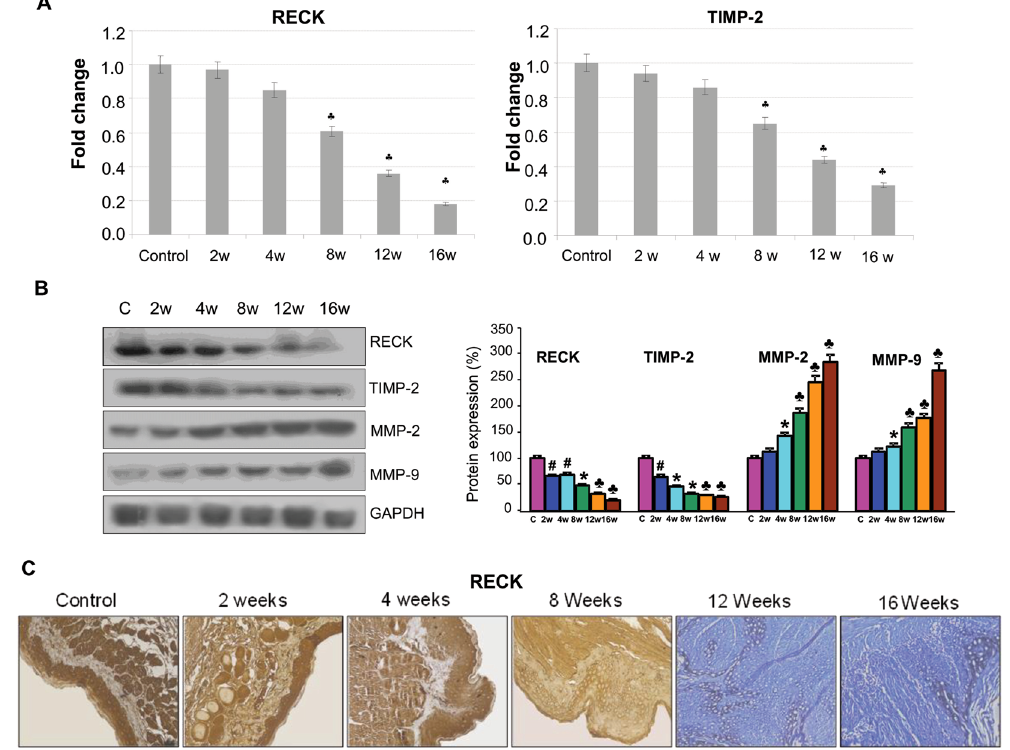
Figure 1. RECK is downregulated during sequential progression of HBP carcinoma. ( A ) qPCR analysis shows that RECK and TIMP-2 are downregulated during sequential progression of cancer. Data are the mean ± SD of three independent experiments (N = 3). ♣ p < 0.001, * p < 0.01, # p < 0.05 versus control. ( B ) Immunoblotting was performed to analyse the expression of RECK, TIMP-2, MMP-2 and MMP-9 in buccal pouch tissues. Data are the mean ± SD of three independent experiments (N = 3). ♣ p < 0.001, * p < 0.01, # p < 0.05 versus control. ( C )Immunohistochemical staining of RECK